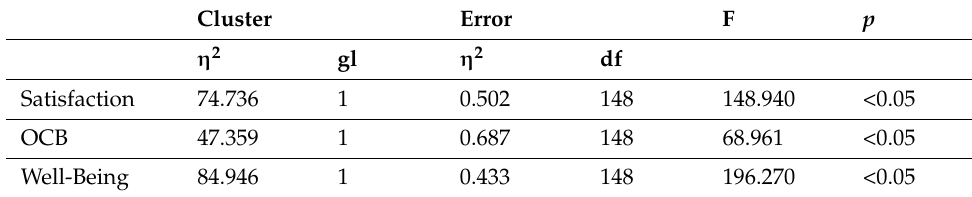
Table 4. ANOVA test